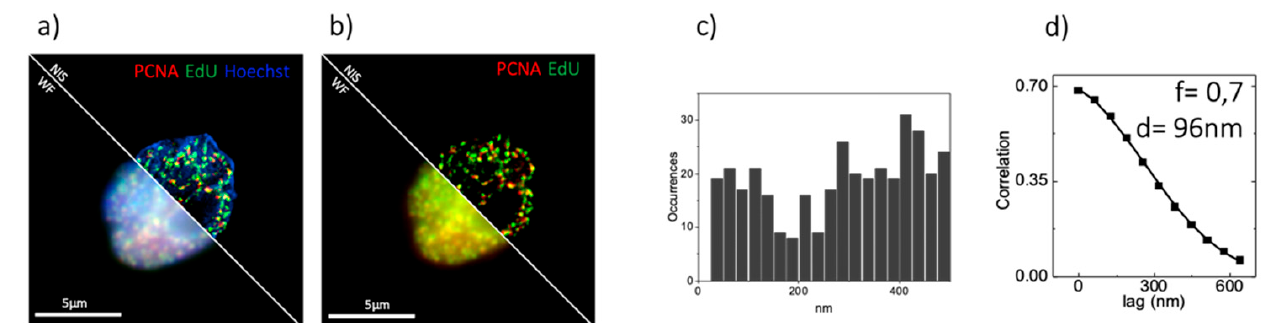
Figure 5. Biological sample of colocalizing nuclear markers. ( a ) Comparison between three color WF and SIM acquisition of PR9-U937 cell line. DNA is stained in blue by using Hoechst, Replication is stained by labeling EdU in green, Replication is marked by labeling RNApol2ser2P in red. ( b ) Two color considered for the colocalization analysis, EdU and RNApol2ser2P. ( c ) Object based analysis on the sample shown in ( b ). ( d ) ICCS analysis on the sample shown in ( b